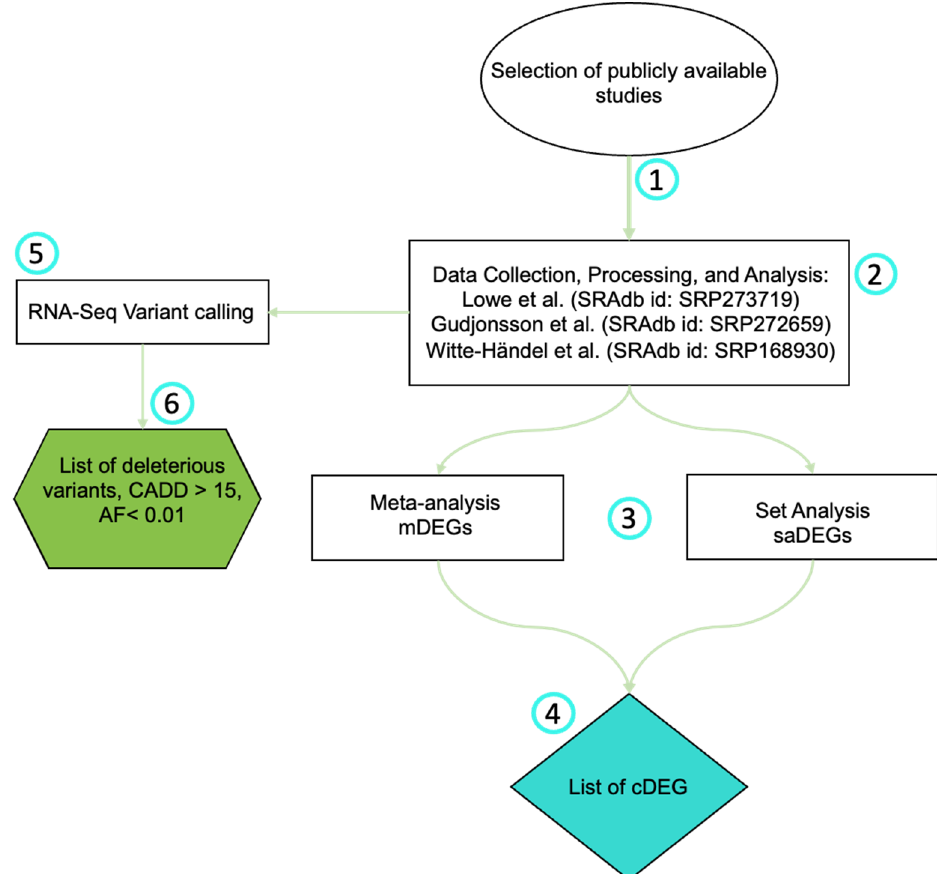
Figure 1. Analysis flowchart: 1: Publicly available studies were selected from the Sequence Read Archive (SRA) and Gene Expression Omnibus (GEO); 2: Three studies passed our selection criteria and were downloaded. SRAdb package for R software version 4.1.0 was used to download all raw. fastq files. Trimmomatic v0.39 was used to trim Illumina adapters and to exclude reads. Resulting gene counts tables were converted into DESeq2 package objects; 3: Lists of DEGs found through the meta-analysis (mDEGs) or the set analysis (saDEGs) (See supplementary data) were created; 4: List of common DEGs (cDEGs) found in both analyses was made (See supplementary data); 5: RNA-Seq variant calling analysis was performed by Strelka v2.9.10; 6: A list of potential HS-related variants originated based on deleterious capacity, allele frequency, and significant genotypic variation based on Wilcoxon Test ( p value < 0.5).